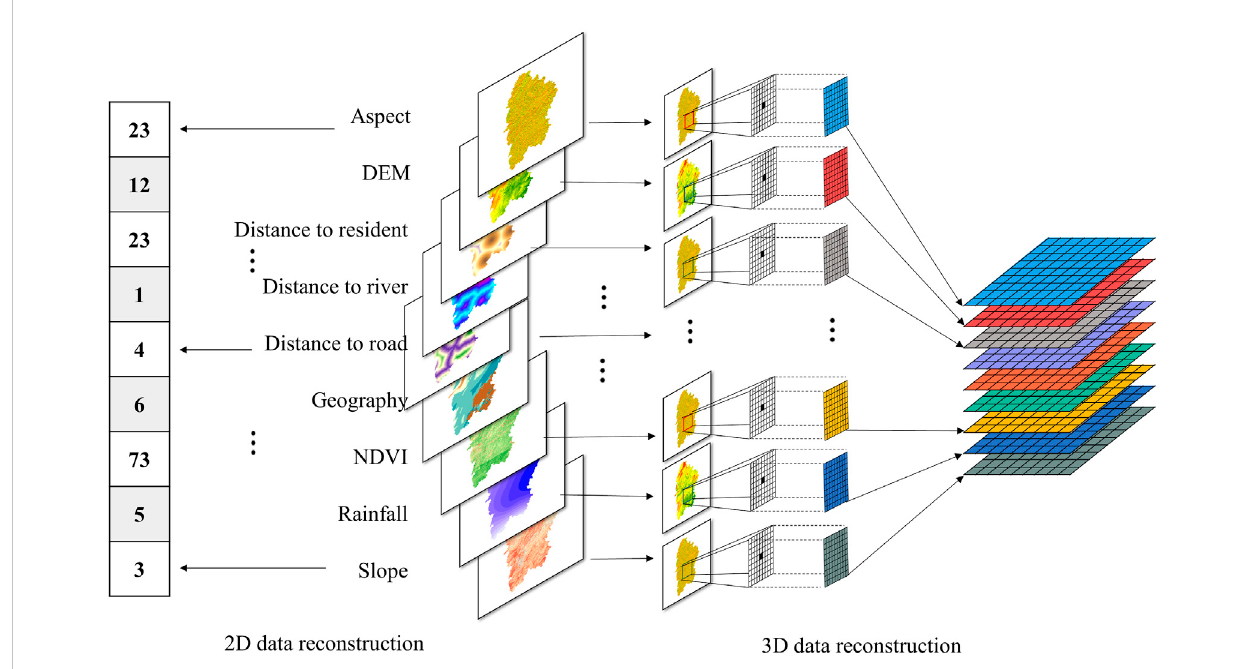
FIGURE 4 Reconstruction of two-dimensional input